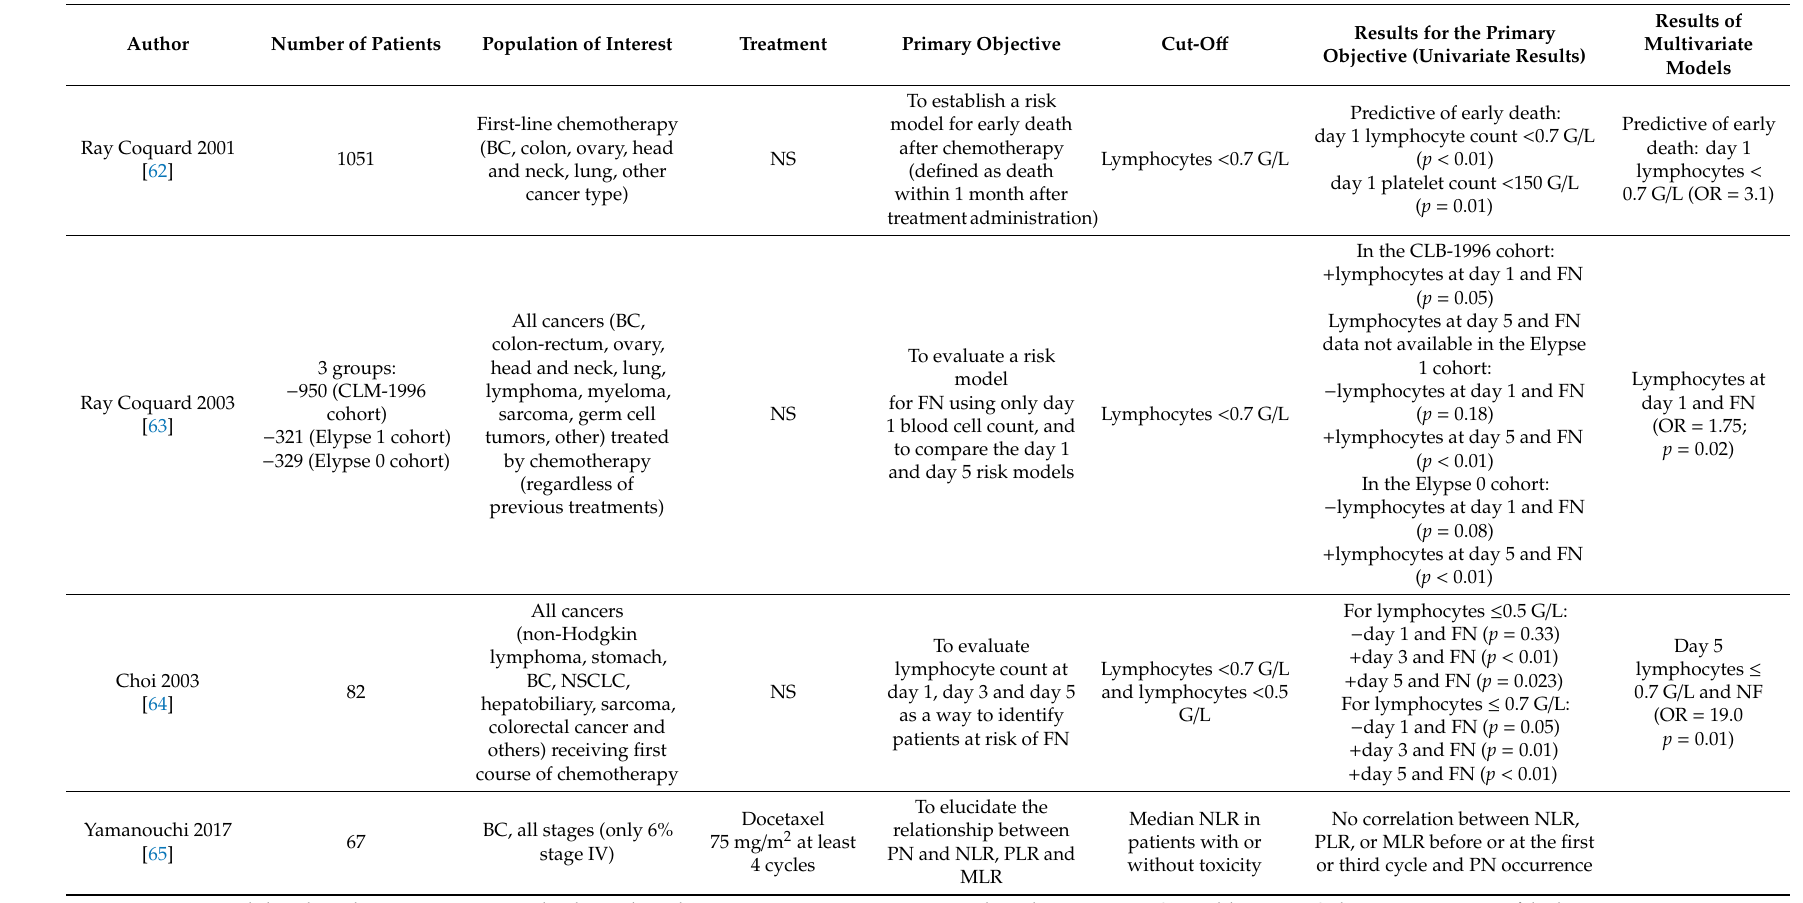
Table 7. Articles with data on inflammatory blood markers as predictive factor of toxicity in patients with breast